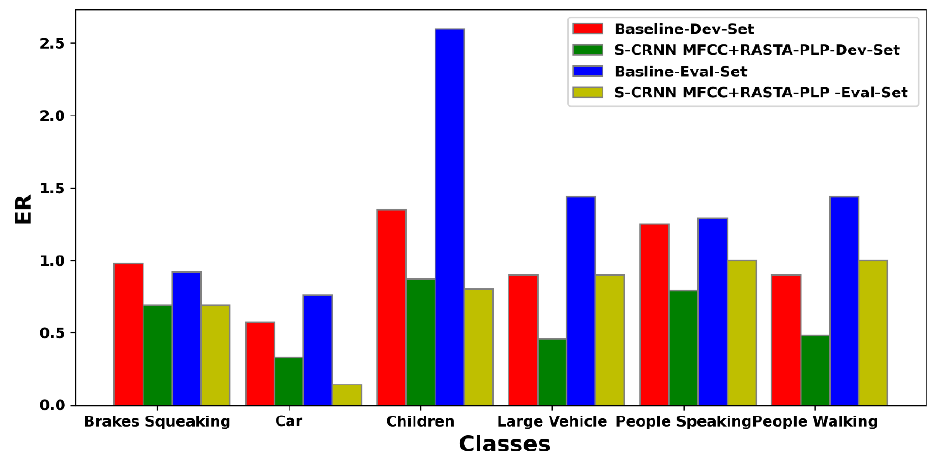
Figure 9. ER comparison using S-CRNN Classifier.